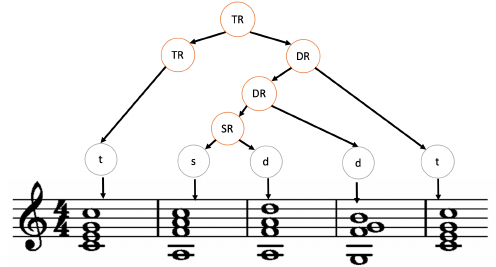
Figure 1. Illustration of a chord